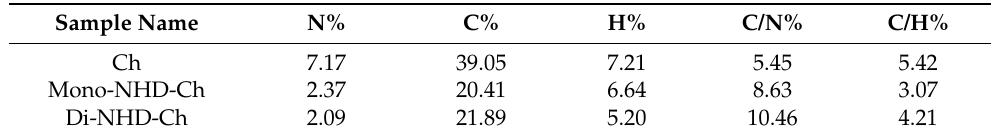
Table 1. Elemental analysis of Chitosan and its Alkyl